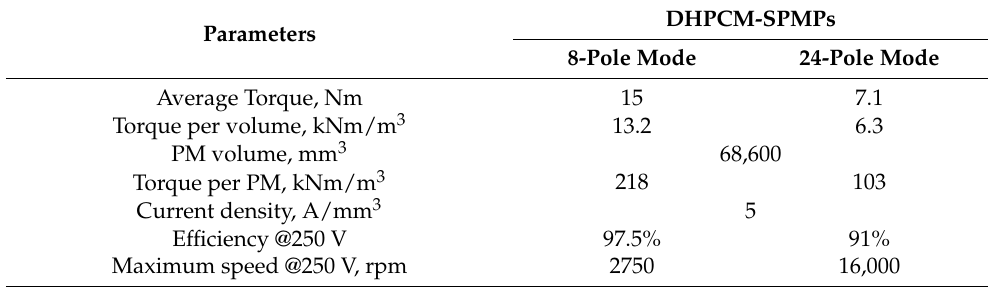
Table 5. Performance parameters of DHPCM-SPMPs.